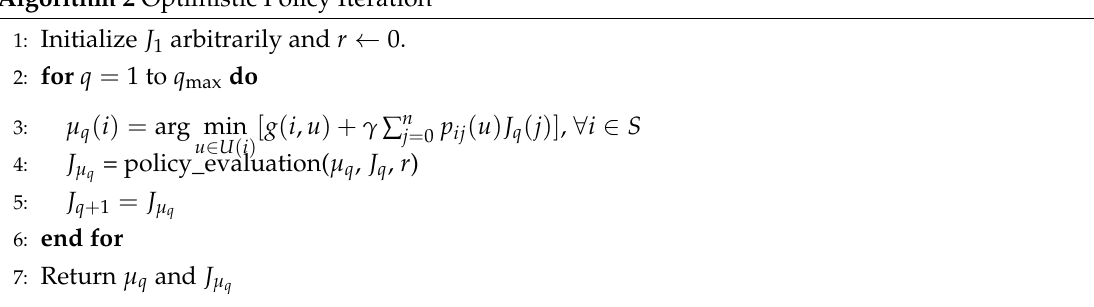
Algorithm 2 Optimistic Policy